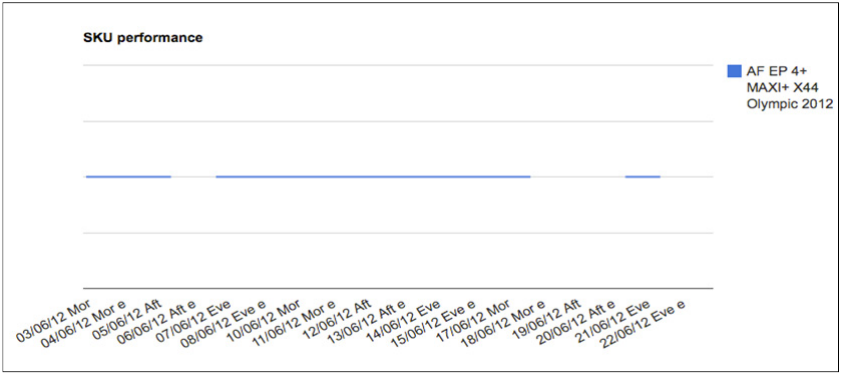
Figure 7. The broken line in the graph shows the OOS period for each